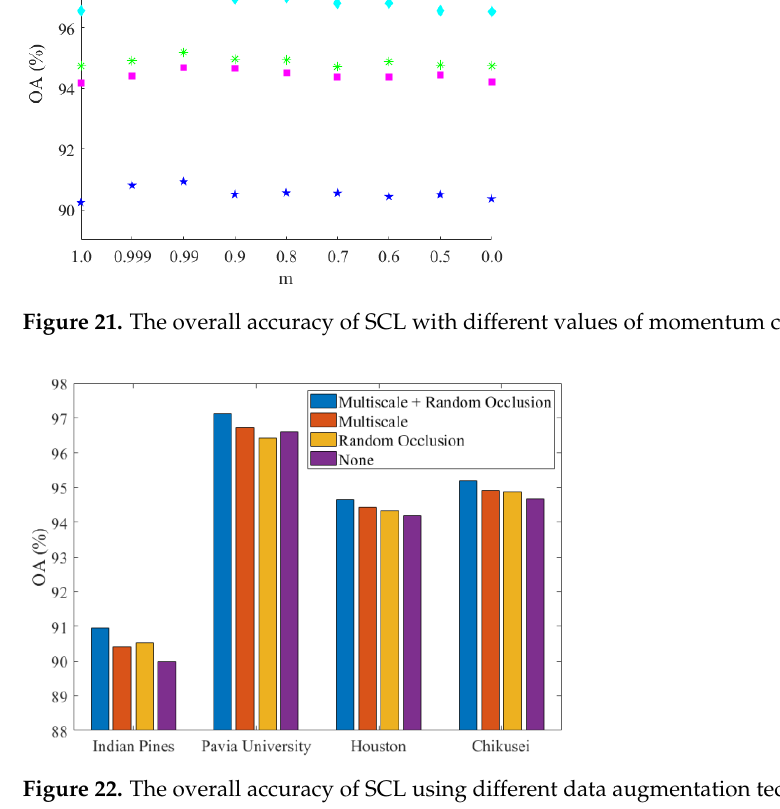
Figure 21. The overall accuracy of SCL with different values of momentum coefficient 𝑚 .